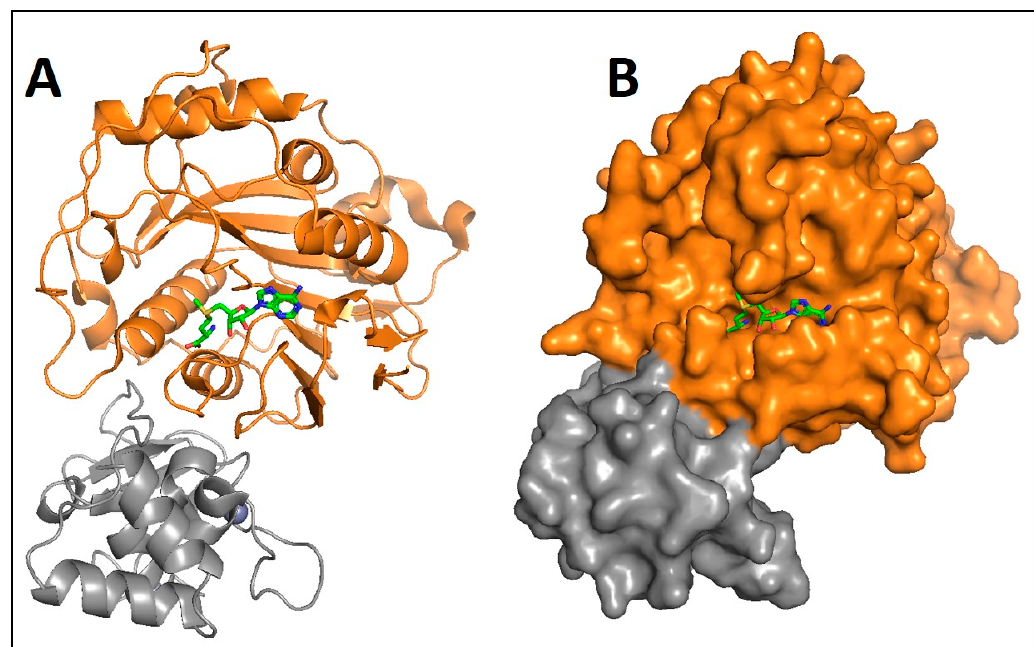
Figure 1. Ribbon ( A ) and Surface ( B ) representation of NSP16 (orange) in complex with NSP10 (grey). S-adenosylhomocysteine (green) is shown at the active site of NSP16. The crystal structure for the NSP16/10 complex was downloaded from the RCSB protein data bank (pdb ID 3R24) [5]. Figures were captured using MacPyMol.